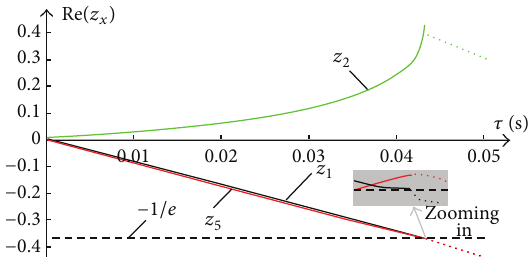
Figure 17: Curves of 𝜏 - 𝑧 1 , 𝜏 - 𝑧 2 , and 𝜏 - 𝑧 5 with set II of Table